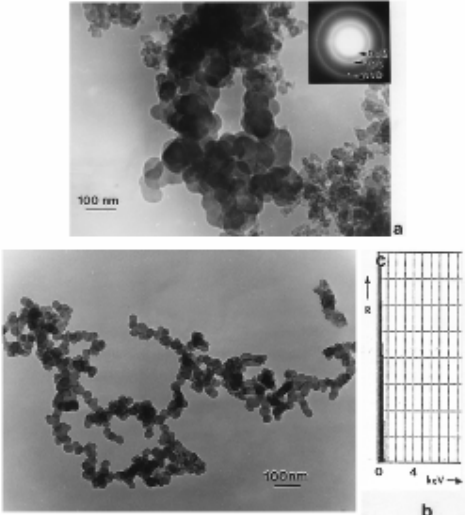
Figure 10: (a) DPM collected from a diesel bus location showing variations in carbon spherule aggregate structures (small and large spherule aggregates). SAED pattern insert shows well-defined graphite diffraction rings. (b) Complex, branched, carbon spherule aggregate characteristic of wood burning (WPM). Note similarity with DPM in Fig. 9(b). The EDS insert shows only